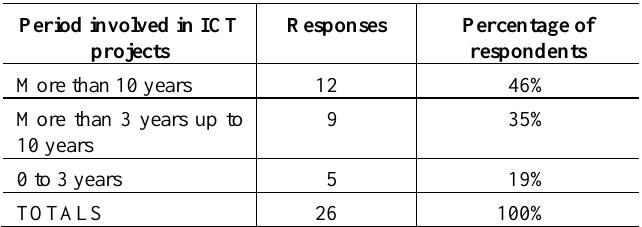
Table 2: Period participants’ involvement in ICT project management